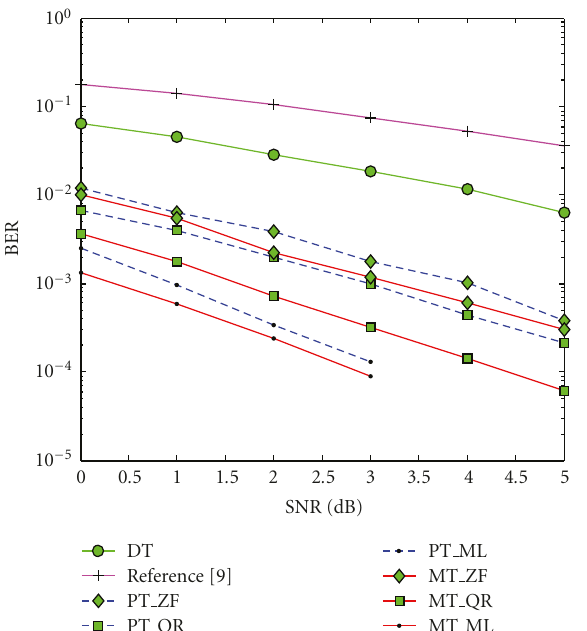
Figure 10: BER versus SNR (SNR in = SNR + 10dB, SNR rd = SNR + 15dB).